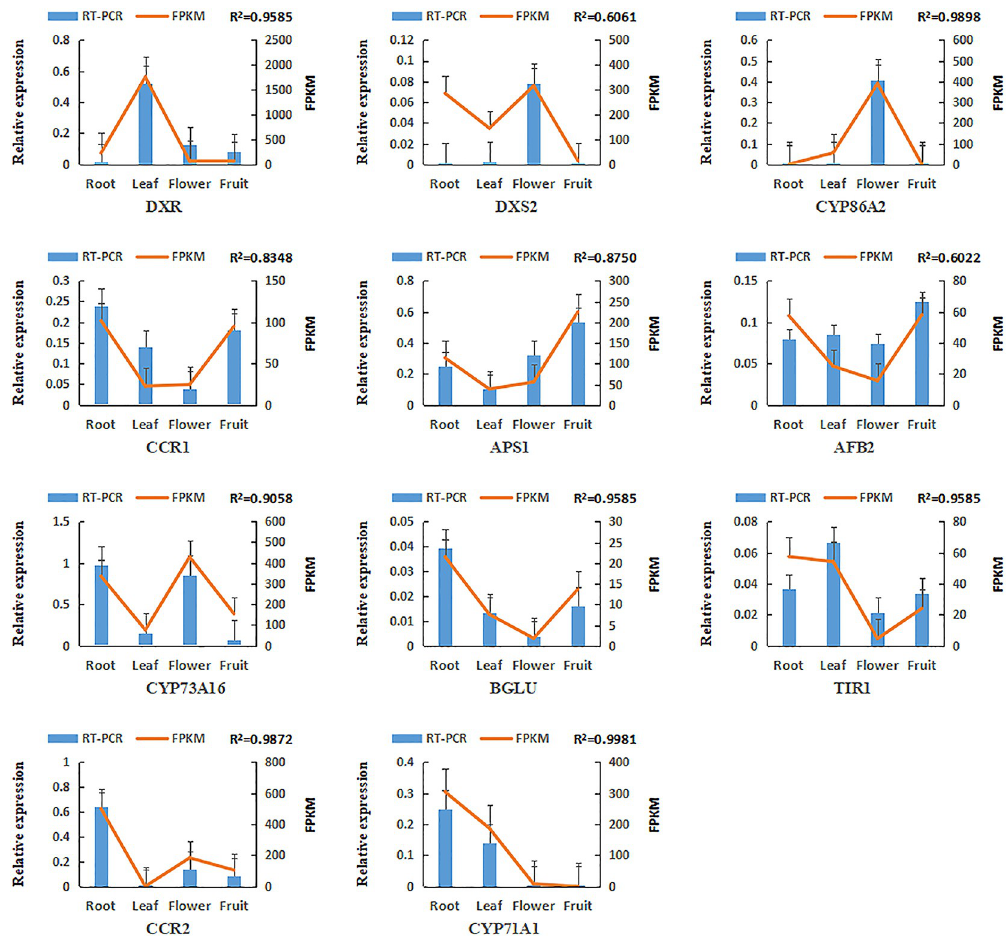
Fig 12. Expressing levels of 11 targeted genes. (The bar charts and linear diagrams indicate the RT-qPCR and FPKM data of the genes, separately. The R 2 value denotes the correlation between the RT-qPCR and FPKM